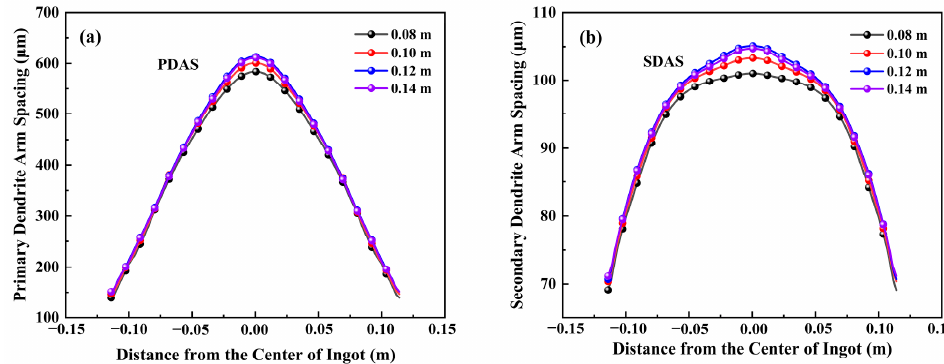
Figure 16. Change of PDAS ( a ) and SDAS ( b ) along radical direction with varying slag thickness.